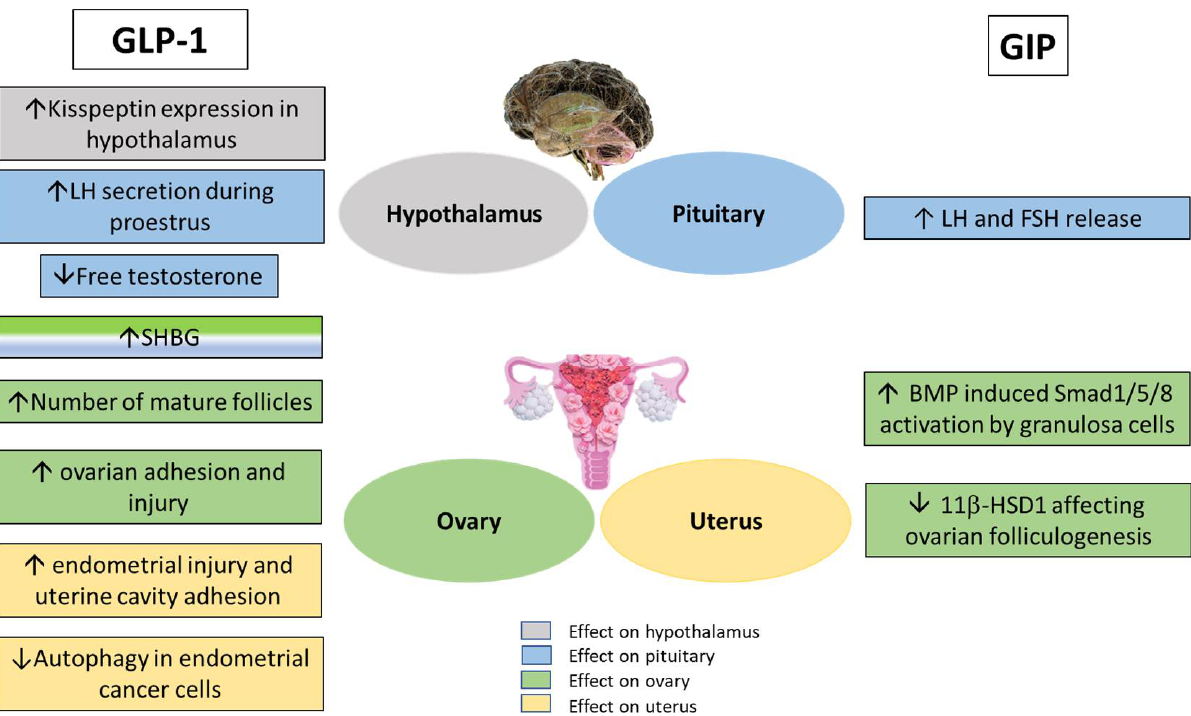
Figure 6. Schematic model showing effects of GLP-1 and GIP receptor modulation on female brain-reproductive function. Arrow up signifies increase/improves; arrow down signifies decrease. Ab- breviations used: BMP-bone morphogenetic protein; Smad1/5/8-transcription factors; 11β-HSD- 11β-Hydroxysteroid dehydrogenase.